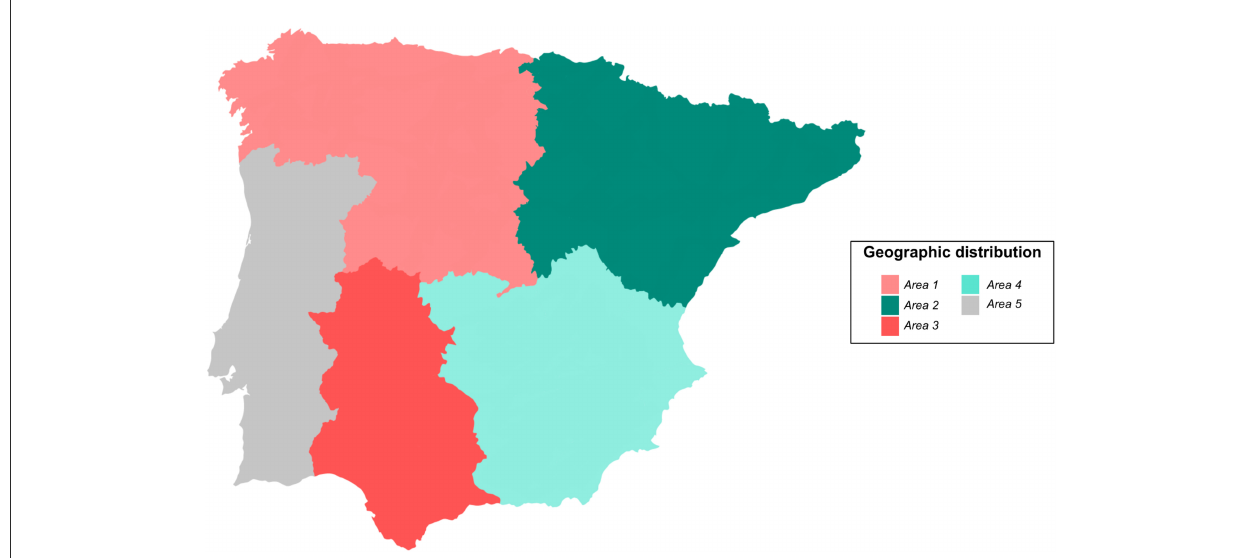
FIGURE1 Geographic distribution of the Iberian Peninsula into areas referring 392 clinical cases of abortion in small domestic ruminants to the diagnostics laboratory between April 2020 and May 2021. Area 1: Northwestern Spain; Area 2: Northeastern Spain; Area 3: Southwestern Spain; Area 4: Southeastern Spain; Area 5: Mainland